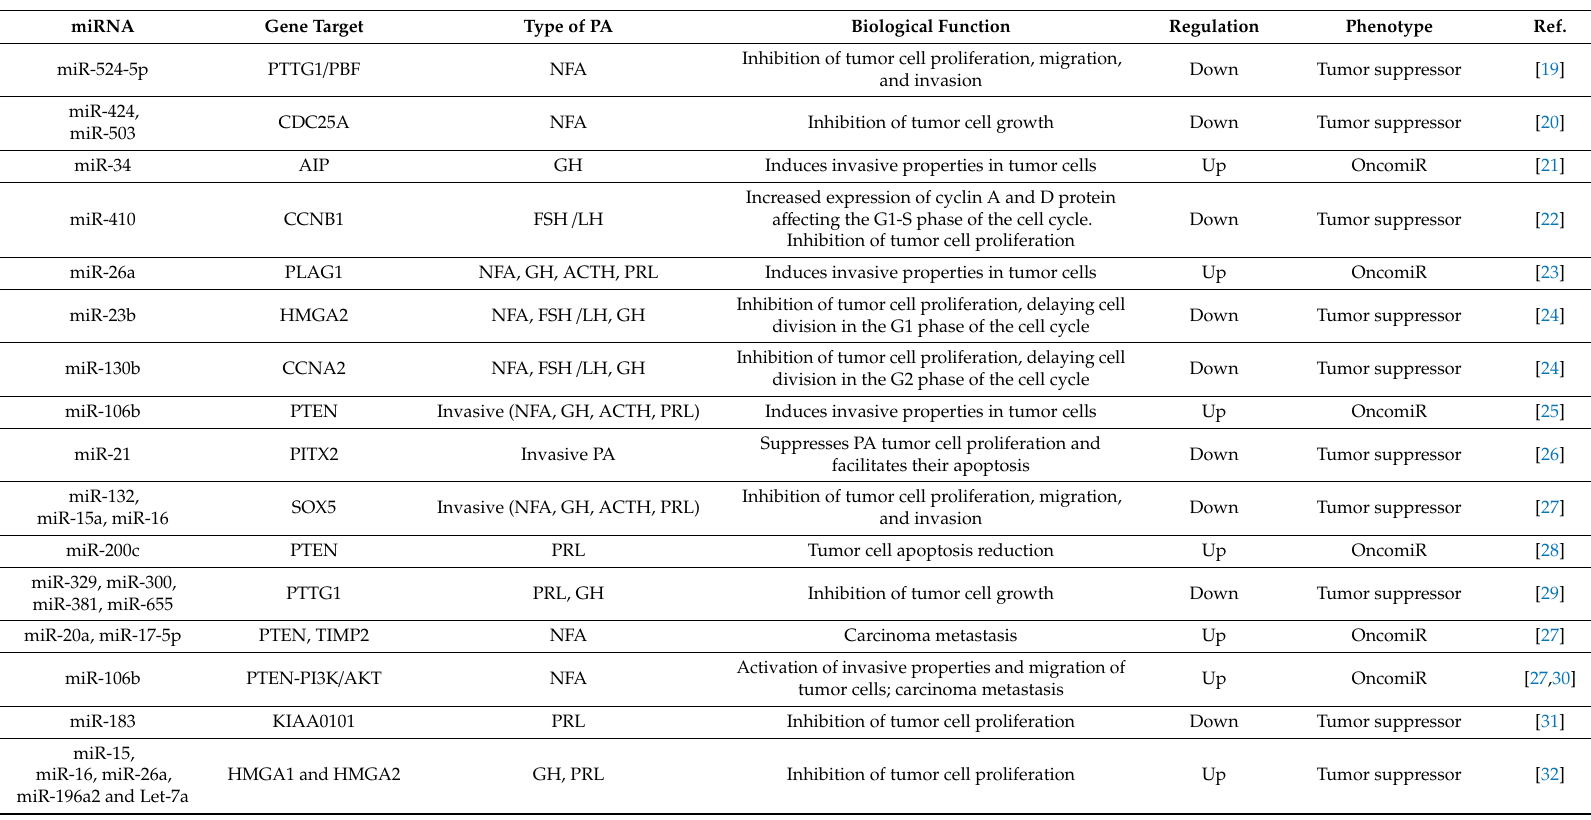
HMGA1 and HMGA2 GH, PRL Inhibition of tumor cell proliferation Up Tumor